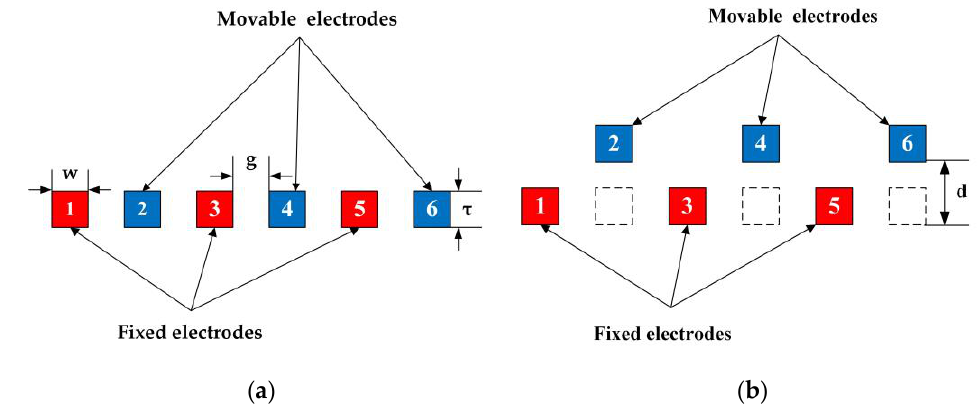
Figure 4. Simulation model. ( a ) Stationary state. ( b ) Moving state.